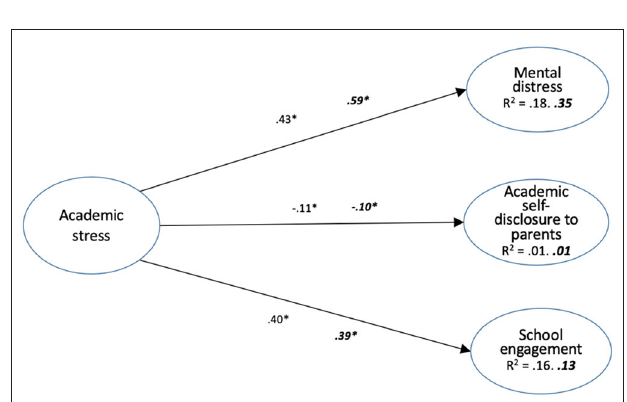
FIGURE 2 | Structural equation modeling of the direct effect of academic stress on males’ and females’ mental distress, academic self-disclosure to parents and school engagement (numbers are standardized effects. *Indicates statistical significance at p <